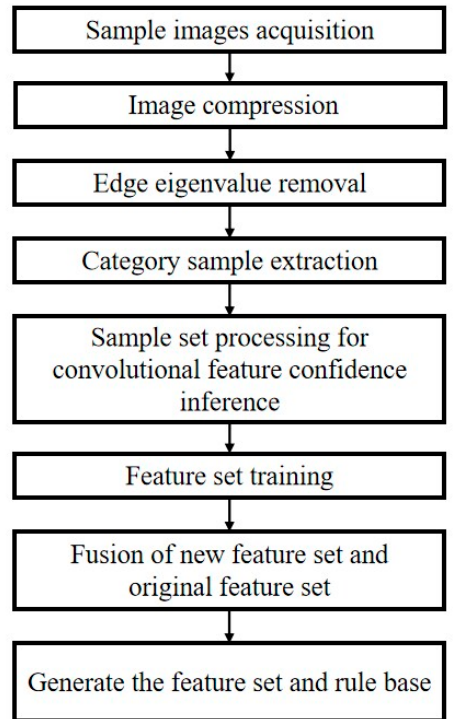
Figure 9. Optimization of the feature set.